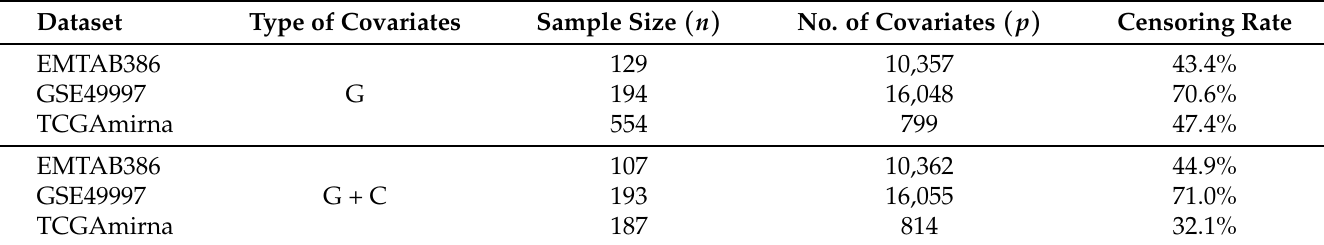
Table 1. Summary of the